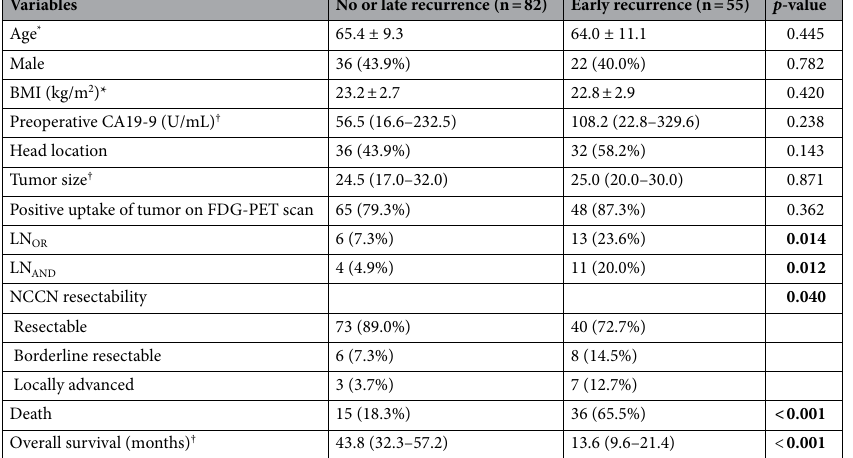
Table 2. Comparison of preoperative characteristics according to the status of tumor recurrence. Data are presented as numbers (%) with the p -values of Fisher’s exact test unless otherwise indicated. *Data are presented as mean ± standard deviation, with the p -value of Student’s t-test. † Data are presented as